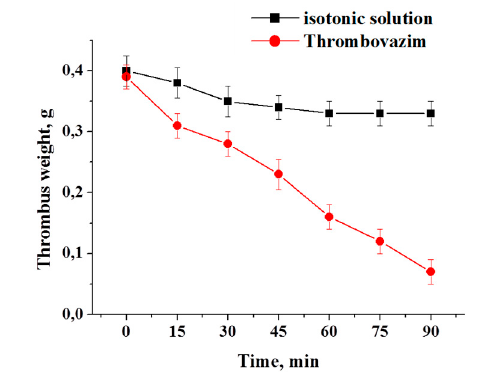
Figure 1. Dissolution of a 2-h thrombus.